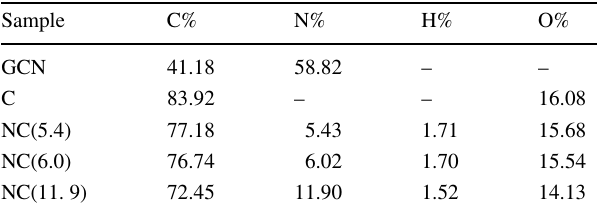
Table 1 Elemental analysis (weight percentage) of the nitrogen- doped carbon nanospheres